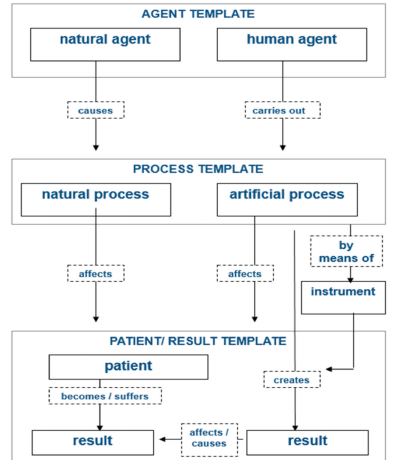
Figure 1. The ENVIRONMENTAL EVENT (http: // ecolexicon.ugr.es / en / aboutecolexicon.htm).